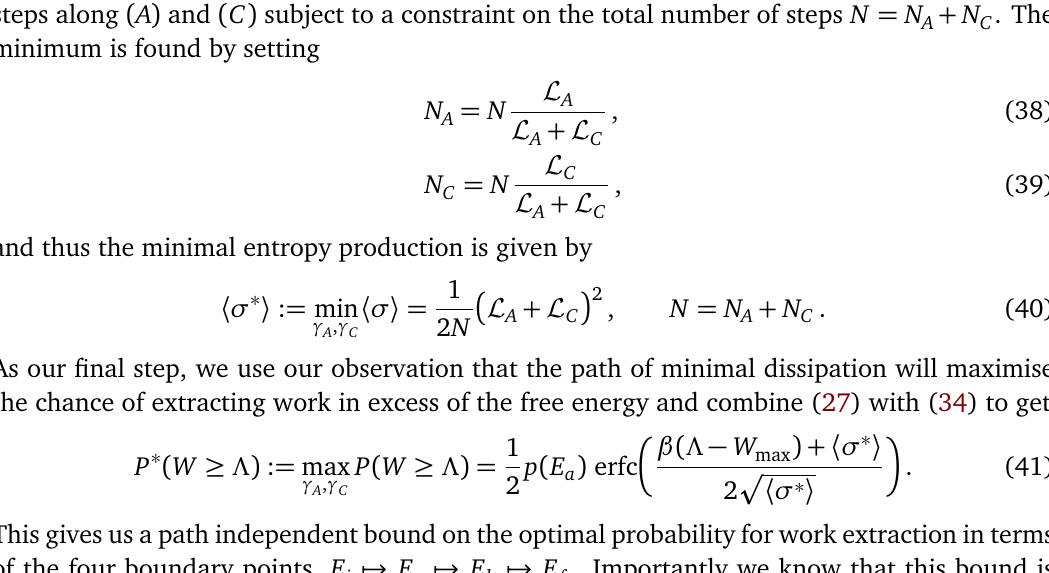
Figure 2: Comparison of P ( W ≥ Λ ) for a geodesic path (see Eq. (37)) and fol- lowing a linear drive of E ( t ) . Parameters: β = 2, E = 0.987 E ∞ ≫ E , E a b a